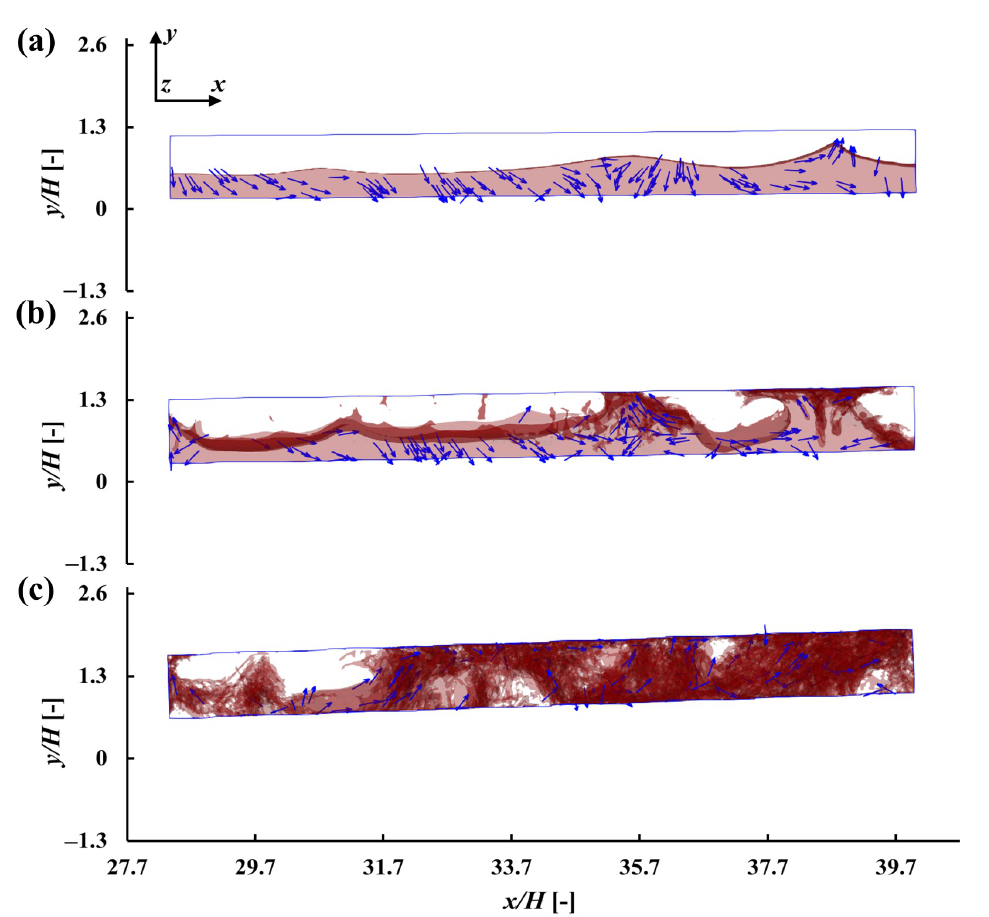
Figure 8. Snapshots for the sloshing tank with N c = 1 at t / T = 2.5 for ( a ) D i = 0.25, ( b ) D i = 0.5 and ( c ) D i = 1.0. Water phase is shown as transparent red with dark red representing the free surface. Blue arrows show the general direction of motion of the sloshing water. The three subplots are points B 0.25 , B 0.5 and B 1.0 , respectively, that presented in Figure 9.